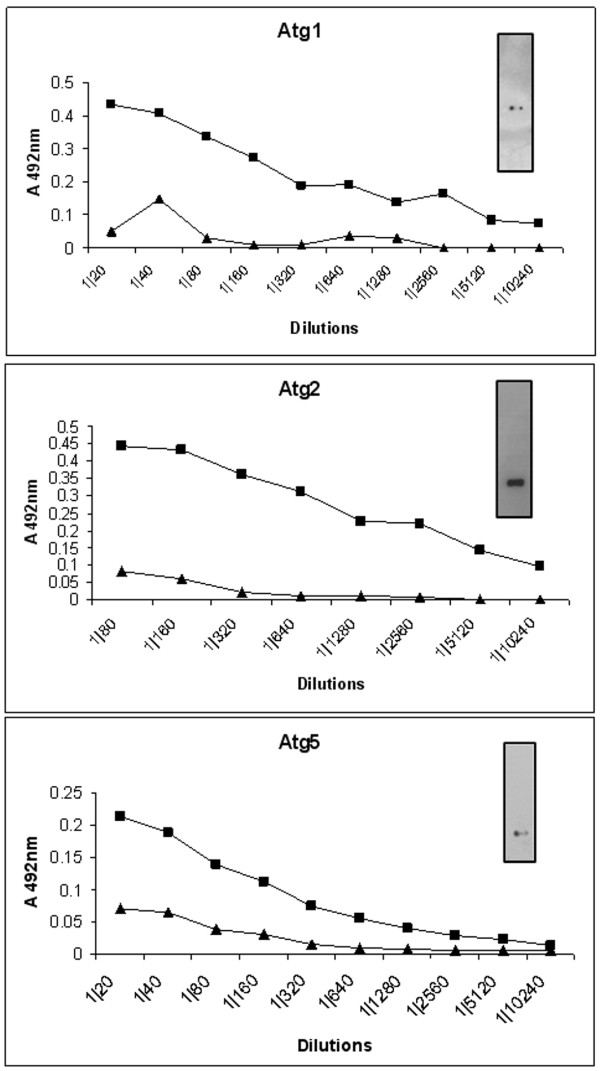
Induction of immune response in BALB/c mice immunized with DNA vaccine. Total IgG against the selected antigens (DNA from Atg1, Atg2 or Atg5) were detected through ELISA in plates coated with the respective recombinant protein. Lines with black triangles and black squares indicate, respectively, pre-immune and final sera (two weeks after the last immunization). Each point represents an average of three different measures of the same immunization. Inserts show the detections of the same proteins by western-blot.